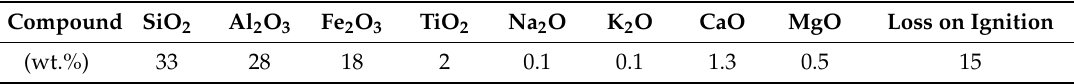
Table 5. Averaged chemical composition of halloyiste from Dunino deposit using an inductively coupled plasma-optical emission spectrometer (ICP-OES). Compound SiO 2 Al 2 O 3 Fe 2 O 3 TiO 2 Na 2 O K 2 O CaO MgO Loss on Ignition